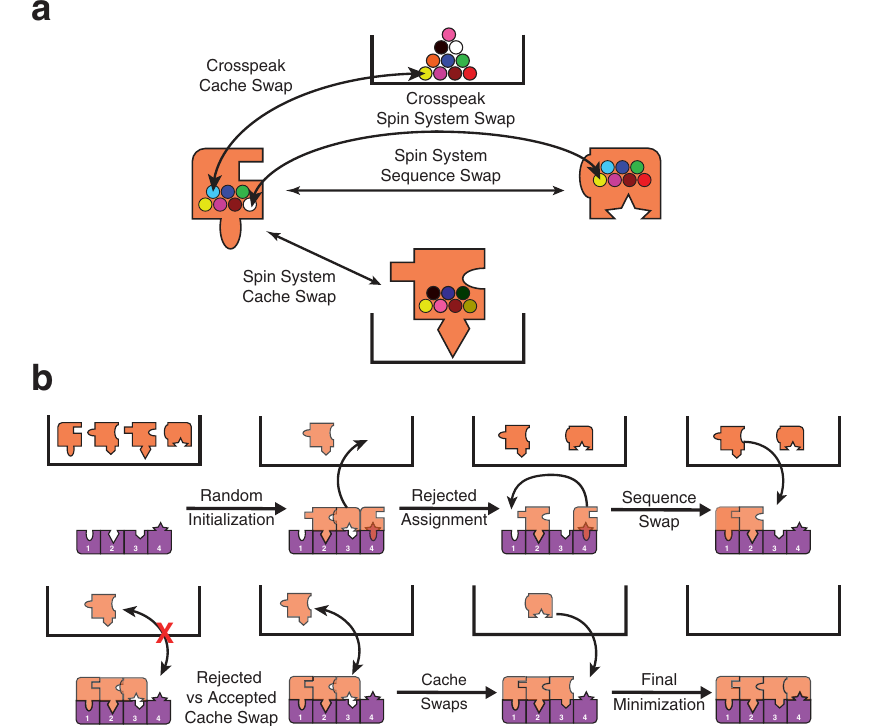
Fig. 2 | Dynamic assembly of spin systems during simulated annealing. a Spin systems(orangepuzzlepieces)begininthecache(blackbox)andareinitializedby random assignment to the sequence (purple pieces). Spin systems can then be swapped with others or moved to different locations of the sequence or to the cache. Spin systems or cross peaks in their respective caches have no priority and are randomlyselected. Swaps are accepted or rejected with a probability based on